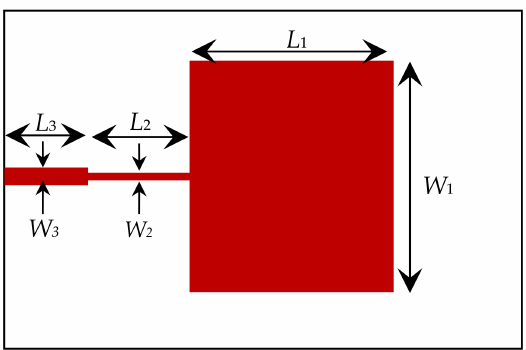
Figure 2. The initial structure of the antenna (conventional microstrip patch antenna).